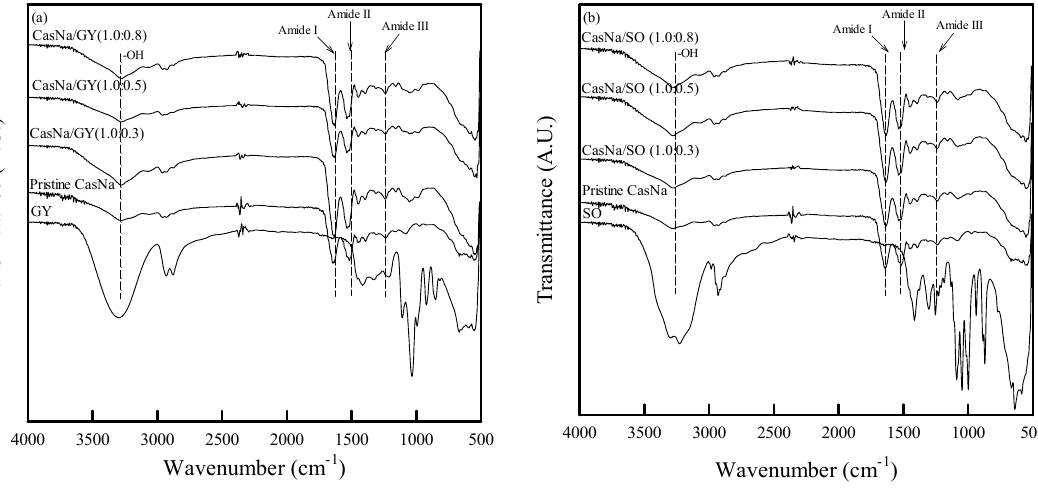
Figure 2. FTIR spectra of ( a ) CasNa/GY–coated papers and ( b ) CasNa/SO–coated papers.